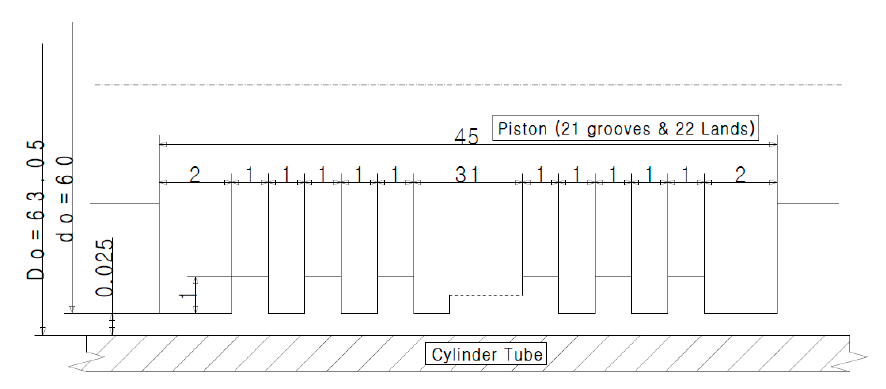
Figure 6. Ring gap for modeling the piston labyrinth seal.